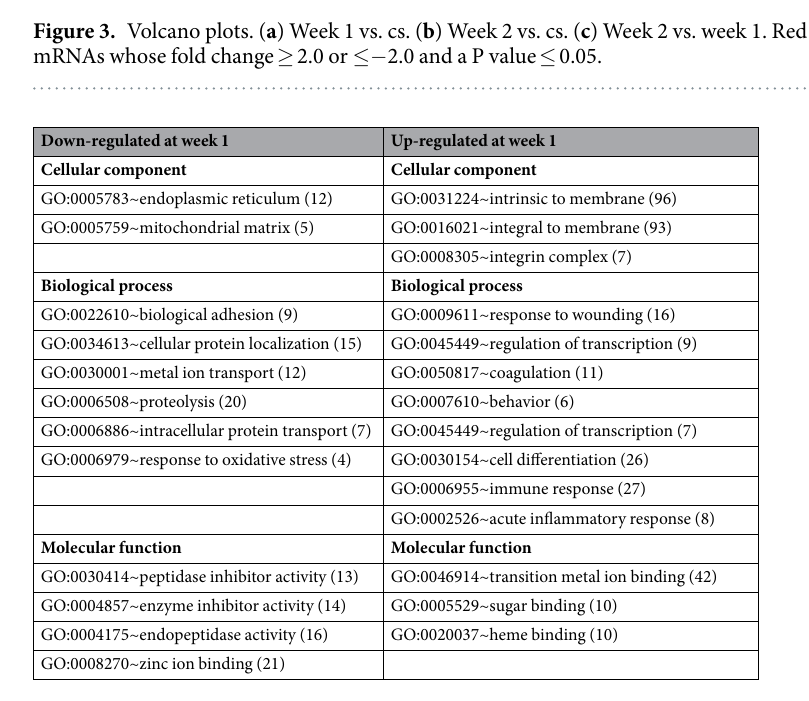
Table 2. Over-represented gene ontology (GO) terms (P < 0.05) in comparison between periosteum of defects site and control site at week 1, with number of genes indicated in